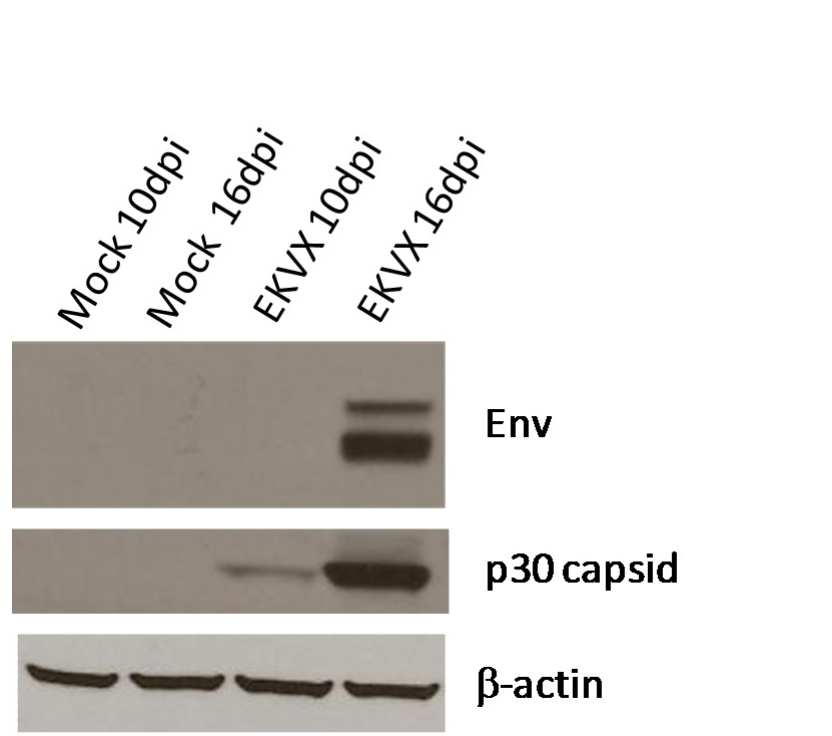
Figure 2. Transmission of infection by a cell-free EKVX supernatant. Subconfluent LNCaP cells were infected with filtered supernatant from EKVX cells (EKVX) or with cell culture medium as a negative control (Mock) in the presence of polybrene. Total protein lysates were prepared at 10 and 16 days post-infection (dpi). Lysates were subjected to electrophoresis and immunoblotting with monoclonal antibody 7C10 for Env and with goat anti-RLV p30 capsid. Immunoblotting with  -actin antibody was used to confirm equal